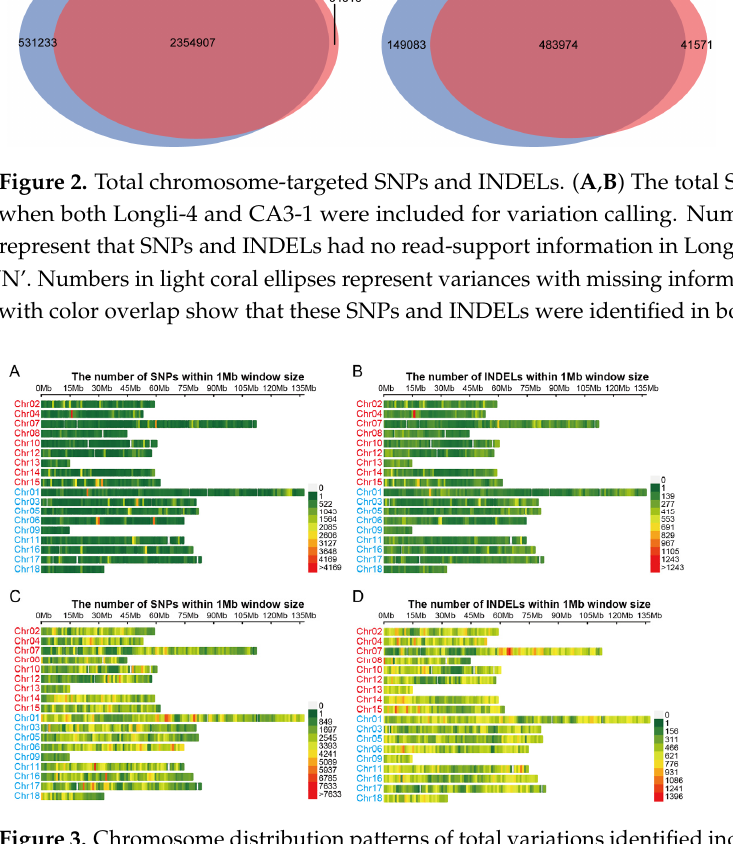
Figure 3. Chromosome distribution patterns of total variations identified individually in Longli-4 and CA3-1 against the reference genome (PI614886). ( A – B ) SNPs ( A ) and INDELs ( B ) of Longli-4 on each chromosome. ( C – D ) SNPs ( C ) and INDELs ( D ) of CA3-1 on each chromosome. The A sub-genome of quinoa includes Chr02, Chr04, Chr07, Chr08, Chr10, Chr12, Chr13, Chr14 and Chr15 and is shown in red, while the B sub-genome includes Chr01, Chr03, Chr05, Chr06, Chr09, Chr11, Chr16, Chr17 and Chr18 and is shown in blue.